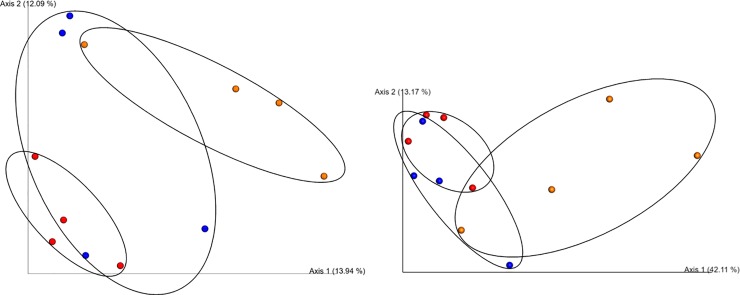
Beta-diversity.When comparing both a Bray Curtis dissimilarity index (A) and a Weighted UNIFRAC PCoA plot (B), successive generations show increasing divergence or dissimilarity from the original community extracted from Round 0 (red), with Round 3 (blue) transitioning between Round 0 and Round 6 (orange) of host-mediated microbiome engineering (HMME).